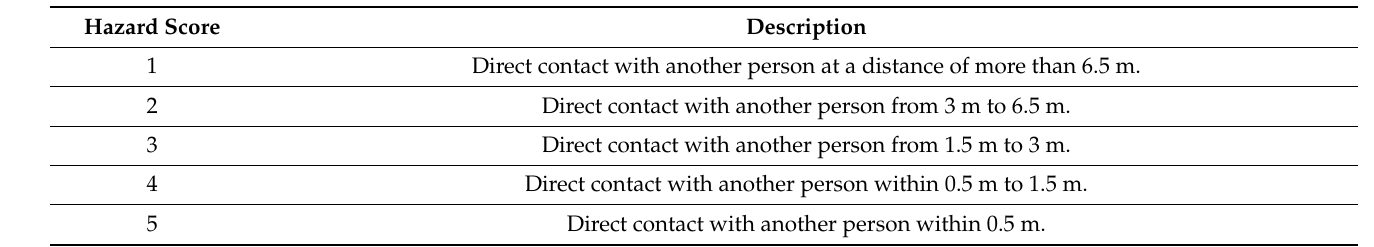
Table 2. Scale of hazards—social distance with another person for the mechanism of infection by droplets. Hazard Score Description Direct contact with another person at a distance of more than 6.5 m. Direct contact with another person from 3 m to 6.5 m. Direct contact with another person from 1.5 m to 3 m. Direct contact with another person within 0.5 m to 1.5 m. Direct contact with another person within 0.5